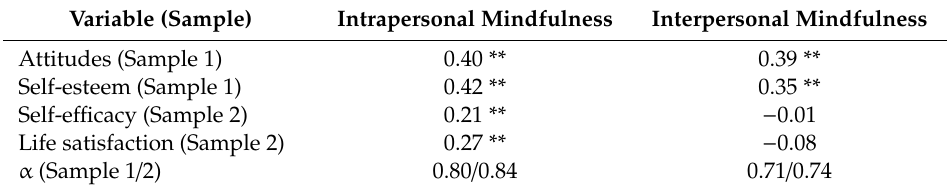
Table 2. Internal reliability and zero-order correlation between mindfulness and theoretically relevant